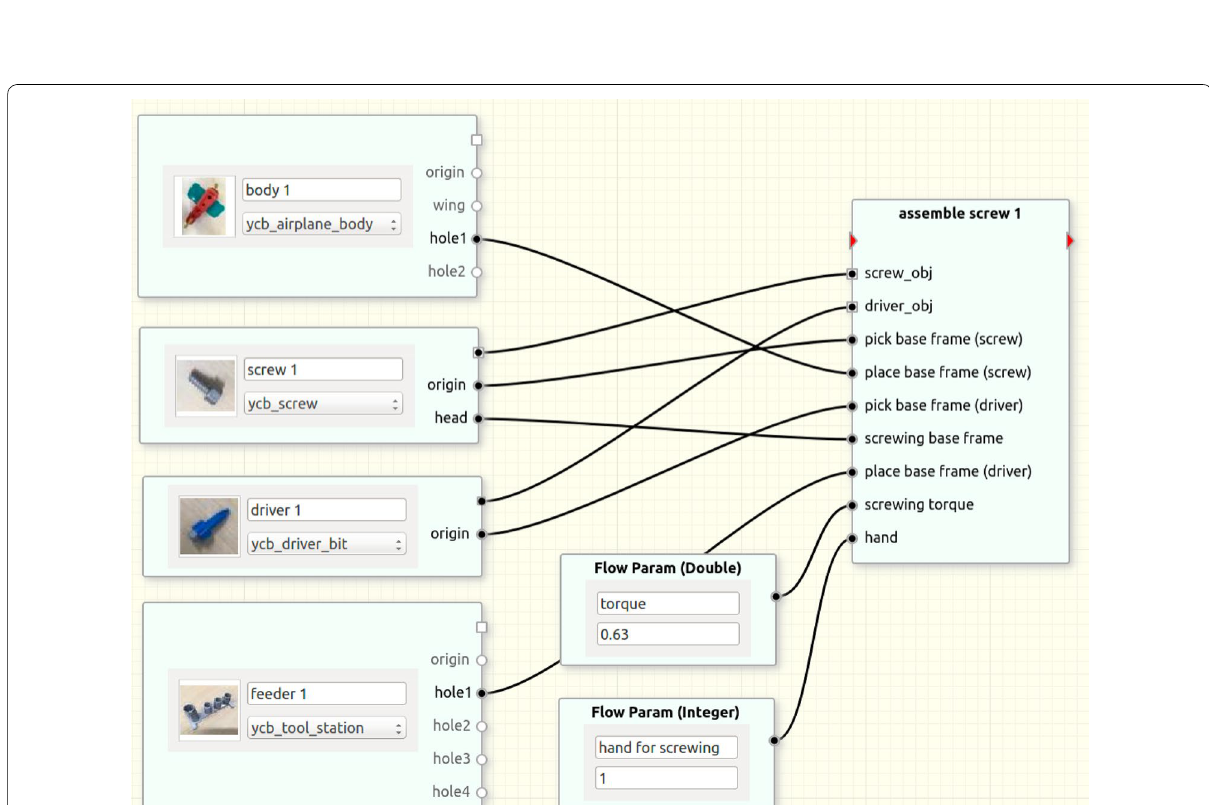
Fig. 17 Dataflow view for a selected